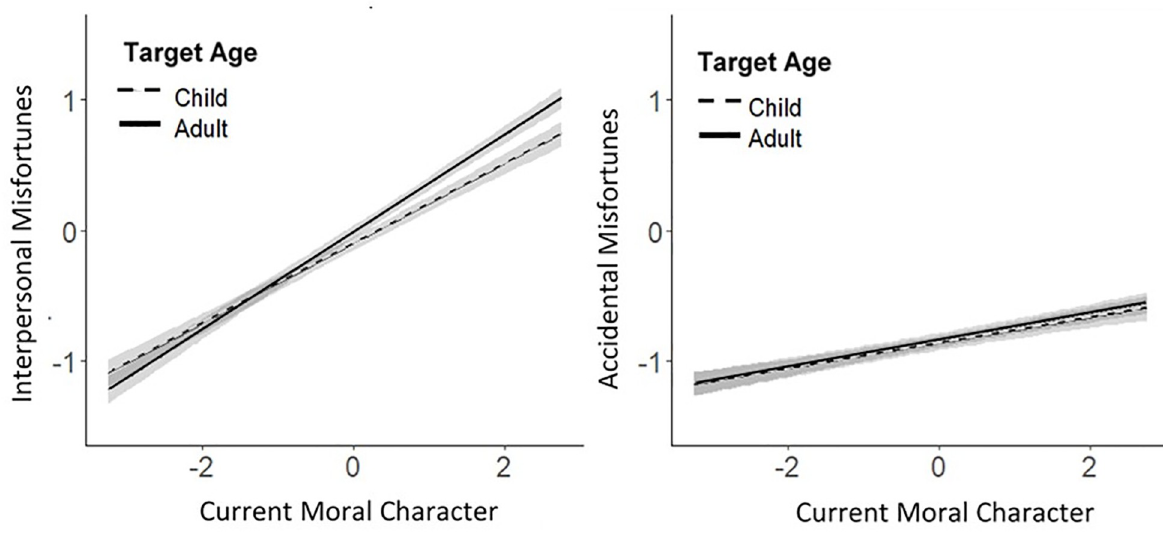
Fig 2. Regression, with 95% confidence bands, showing that the target’s age (adult or child) moderated the relationship between inferences about current moral character and forecasts about future interpersonal (but not accidental) misfortunes. Regression lines are plotted from data aggregated across all